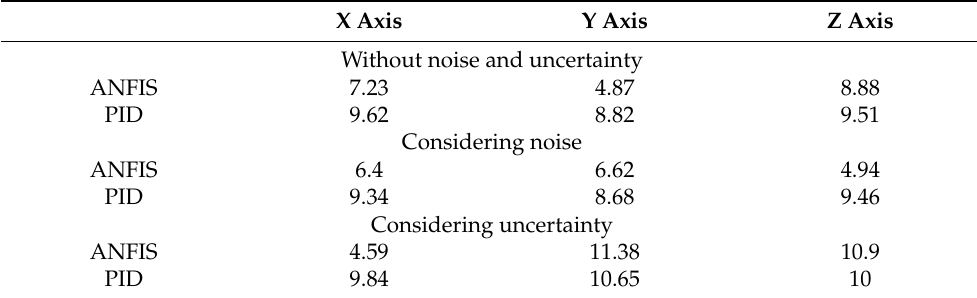
Table 4. Settling time for 1% error for satellite Euler angles using PID and ANFIS controllers (in seconds). X Axis Y Axis Z